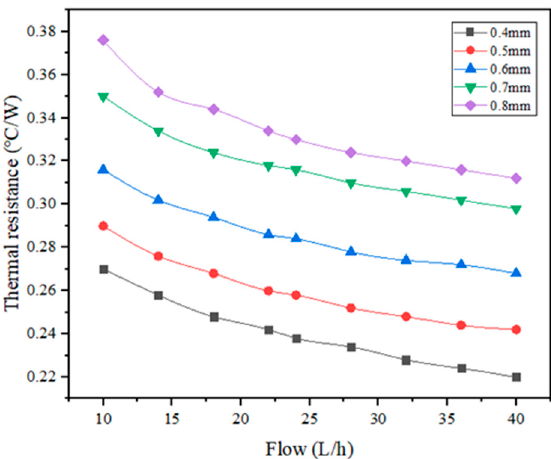
Figure 9. Variation curve of thermal resistance of double-layer microchannel heat sink with coolant flow under different hydraulic diameters.